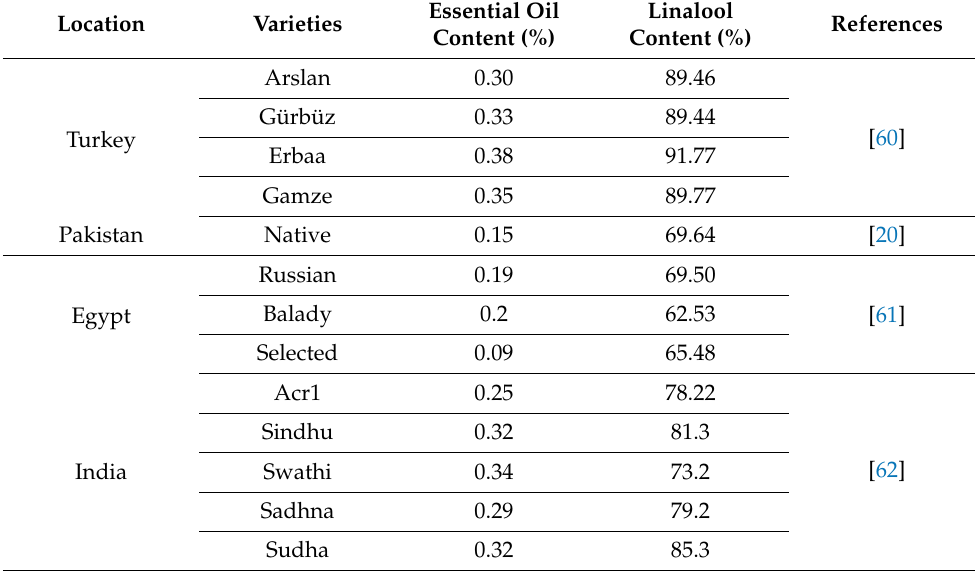
Table 3. Variation of coriander essential oil among different varieties of